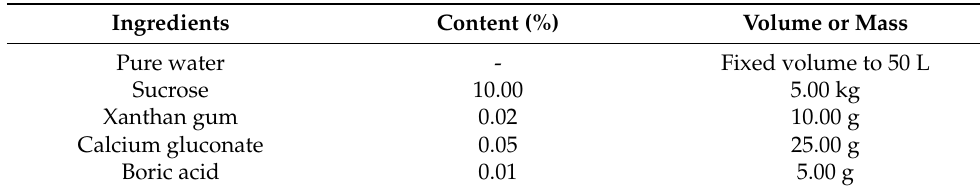
Table 1. Composition of pear pollen solution. The table contains the composition, content, and mass (volume) of each component in the pollen